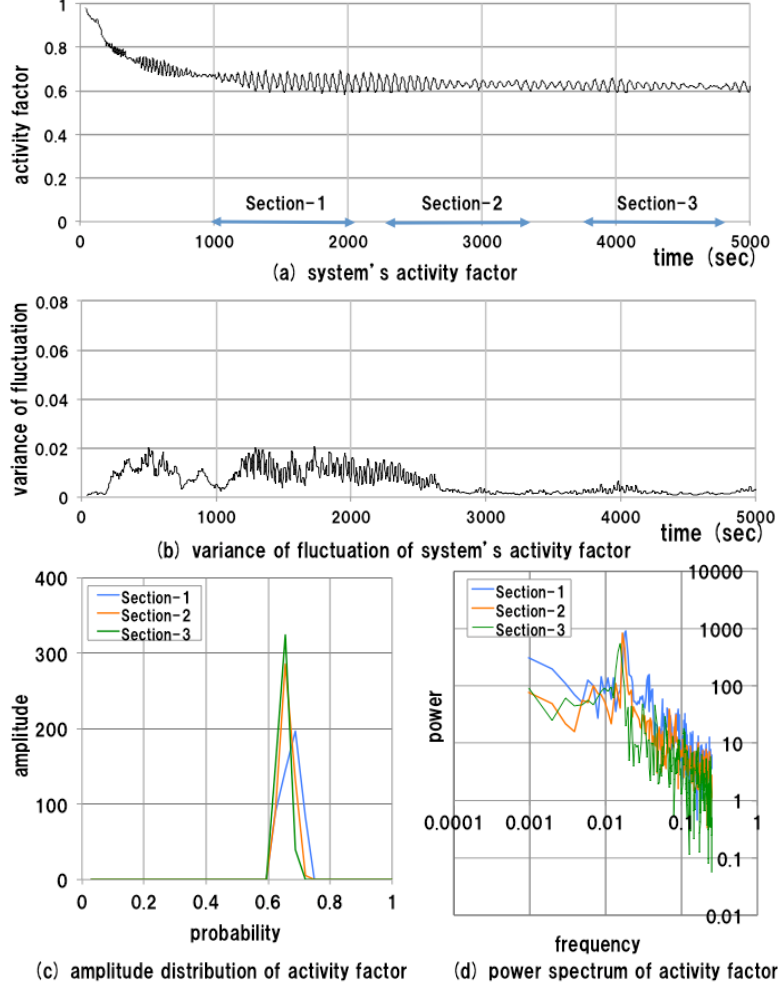
Figure 7. Results of measurements of the normal test bed